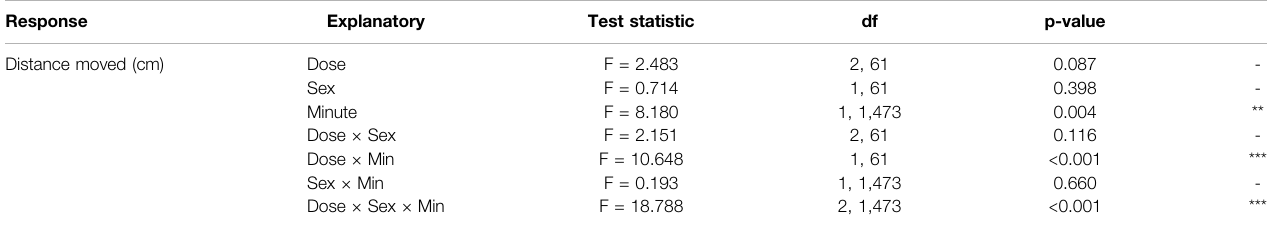
TABLE 1 | Results of the linear mixed-effects model of Distance moved (cm) per minute, with fi xed effects of Minute, Dose and Sex and all interactions, and a random intercept of individual. Response Explanatory Test statistic df p-value Distance moved (cm) Dose F = 2.483